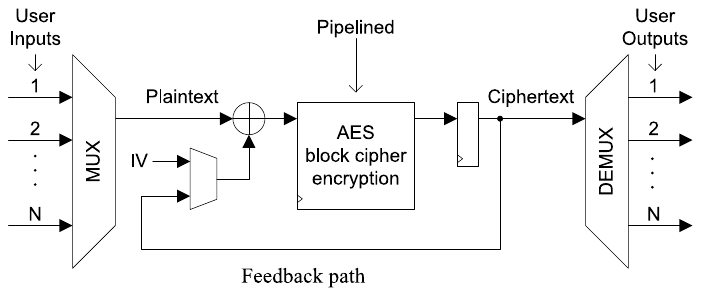
Figure 13. Block diagram of AES encryption cipher application in the CBC block